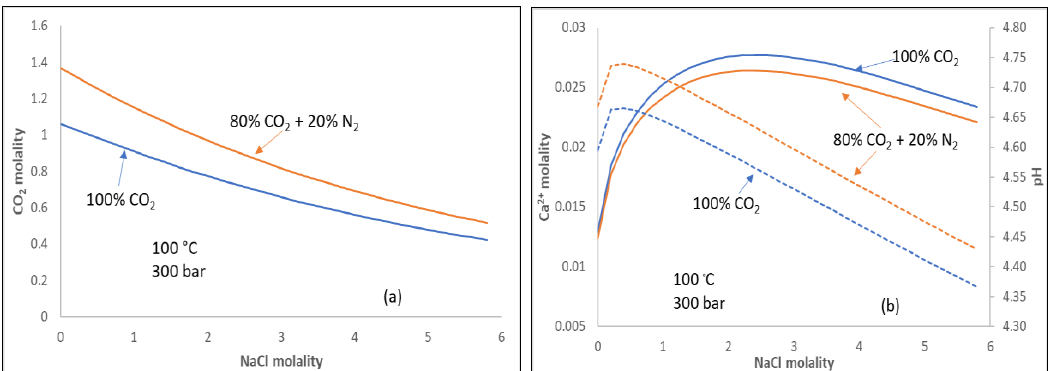
Figure 13. Phase equilibria of CO 2 -brine-calcite and CO 2 -N 2 -brine-calcite at 100 (°C) and 300 (bar). ( a ) CO 2 molality varying with NaCl molality. ( b ) Ca 2+ molality and pH varying with NaCl molality; solid lines are Ca 2+ molality, and dashed lines are pH.